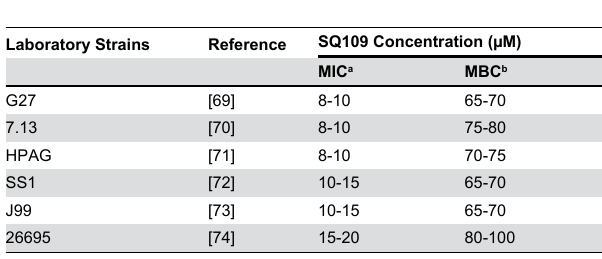
Table 1. Antimicrobial Activity of SQ109 against H. pylori Laboratory